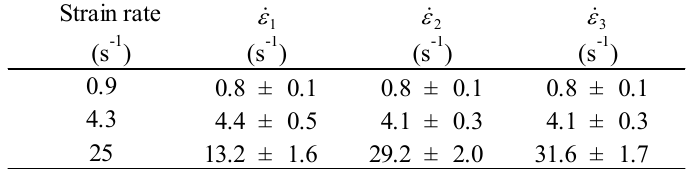
Table 3: Comparison of preset rates and those measured in strain-time curves (mean ±